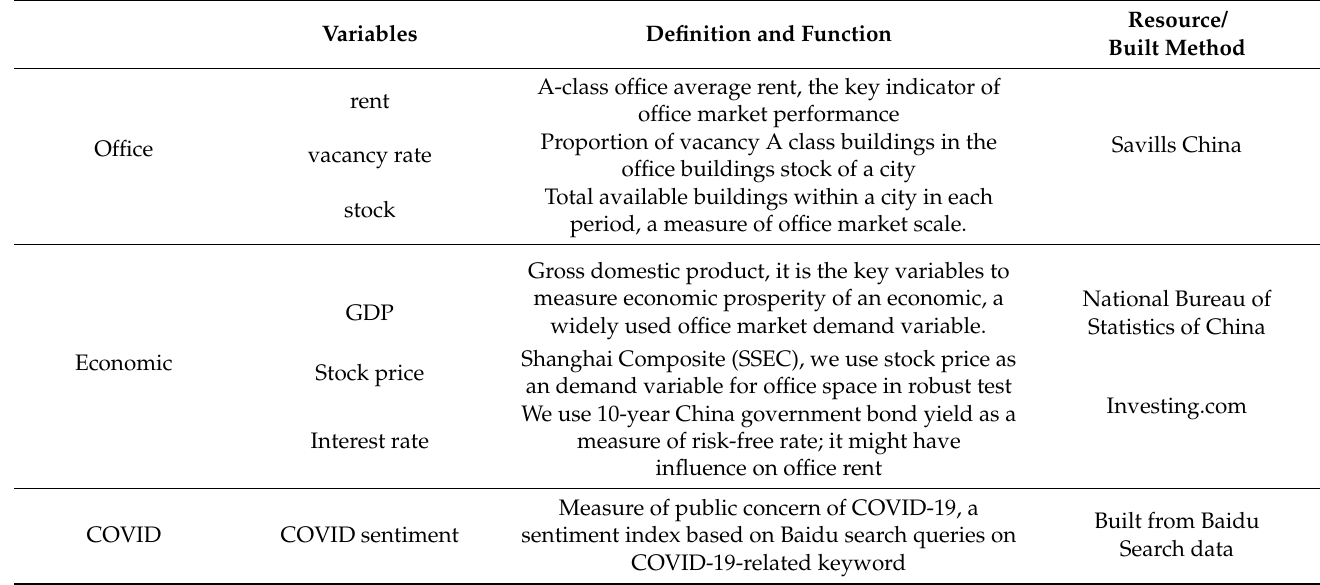
Table 1. Key variables and data